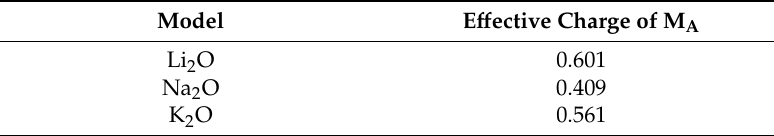
Table 3. E ff ective charges of M A of reverse fluoride structures. Table 3. Effective charges of M A of reverse fluoride structures.